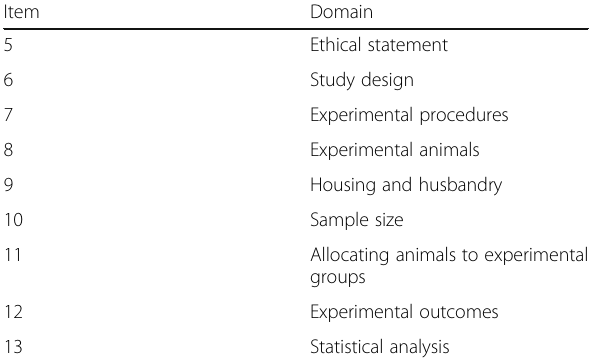
Table 5 Items of the ARRIVE Guidelines [18] Item